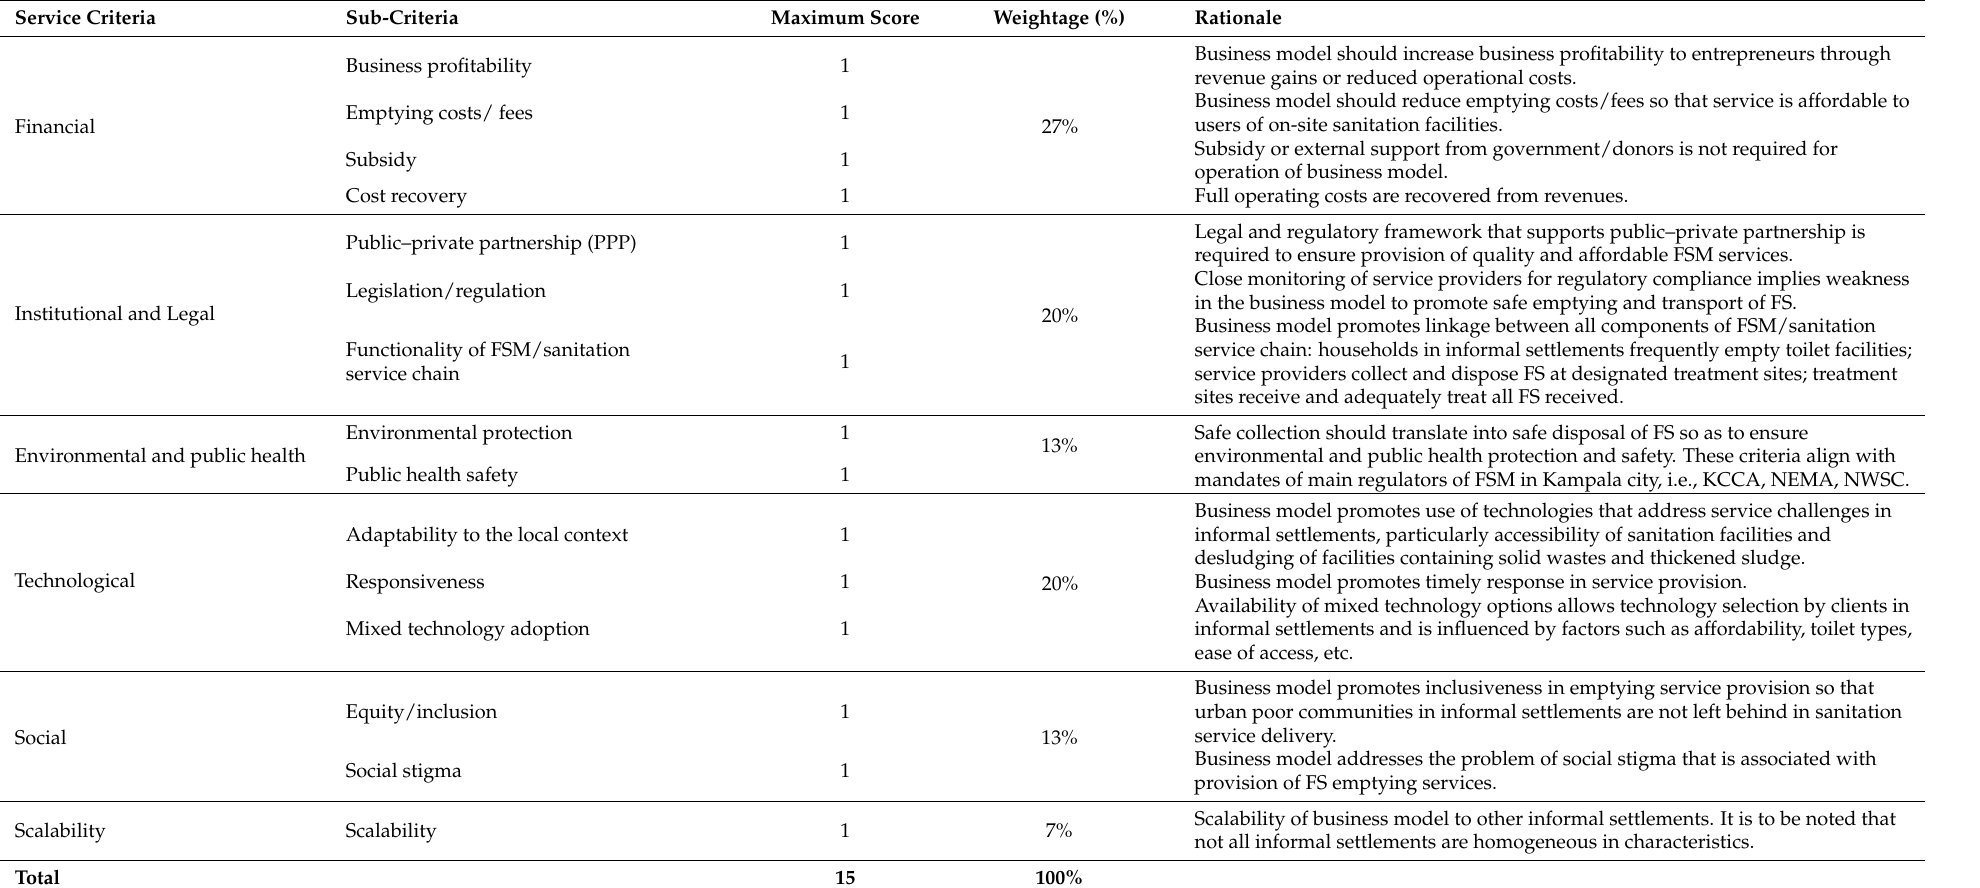
Table 1. Service criteria and sub-criteria of evaluation framework (adapted from